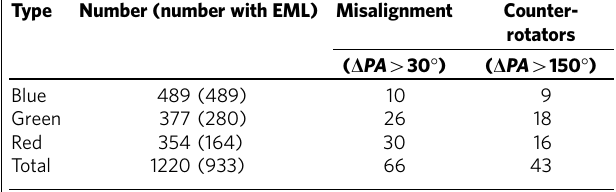
This table gives the number of galaxies in each catagory. blue: blue star forming galaxies; green: greenvalley;red:redquiescentgalaxies.Misalignmentandcounter-roatorsareclassifiedby D PA given in the table. EML means galaxies with emission lines; the number of galaxies with line emission is in